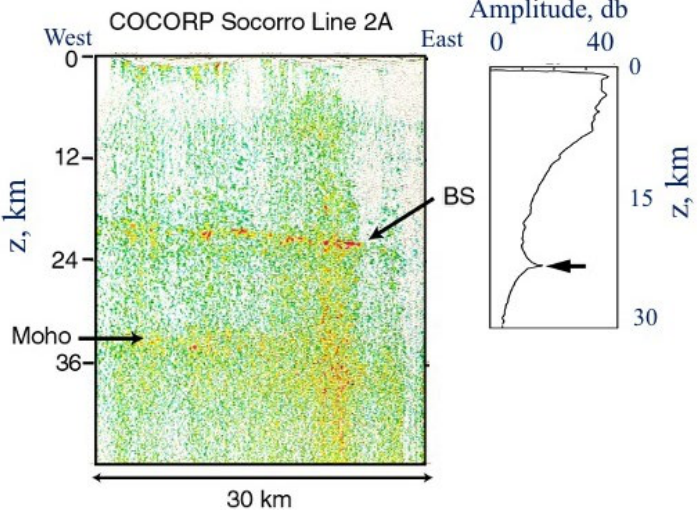
Figure 2. ( Left ) “True Amplitude” deep seismic reflection section showing a “bright spot” interpreted to mark magma in the mid-crust in the central Rio Grande Rift. ( Right ) reflection amplitude vs. depth for the sum of raw seismic traces quantifying the anomalous nature of the reflection amplitude of the Socorro Bright Spot (COCORP Line 1; [36,45]).